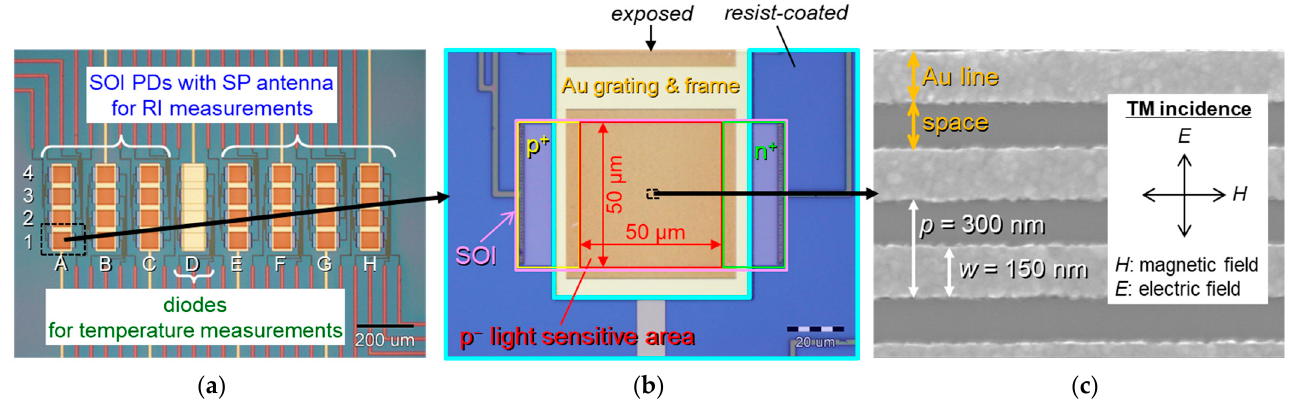
Figure 2. Top-views of microscopic images of fabricated devices. ( a ) Integrated silicon-on-insulator photodiodes (SOI PDs) with surface plasmon (SP) antenna and diodes on a chip. First, 4 × 7 PDs (column A to C and E to H) and 4 × 1 (column D) diodes are arranged for refractive index (RI) measurements and temperature measurements of analyte, respectively. ( b ) A single SOI p–n junction PD with SP antenna. The SP antenna is exposed to sense refractive index (RI), and the other area is protected by photo-resist to avoid unexpected electrical short through aqueous solution. ( c ) Scanning electron microscope (SEM) image of a gold (Au) line-and-space (L/S)-type SP antenna with the grating period of p = 300 nm. The inset is the definition of incident polarization to the grating direction.